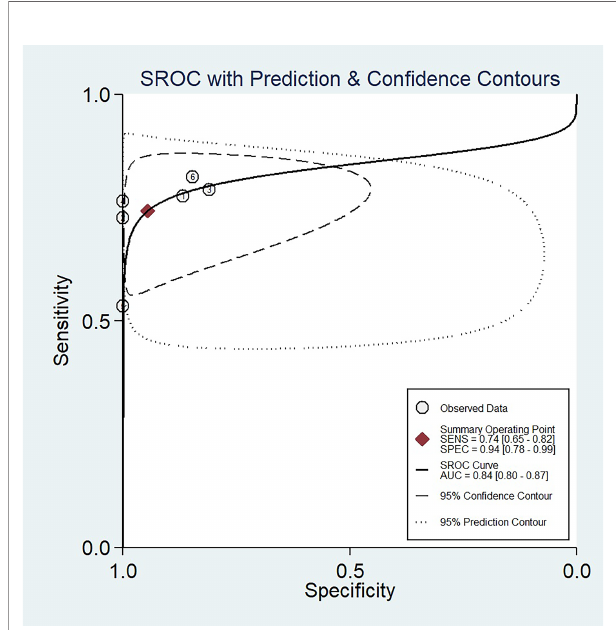
FIGURE 4 | The summary receiver operating characteristic (SROC) curve of the diagnostic performance of DWI for differentiating malignant from benign IPMNs of the